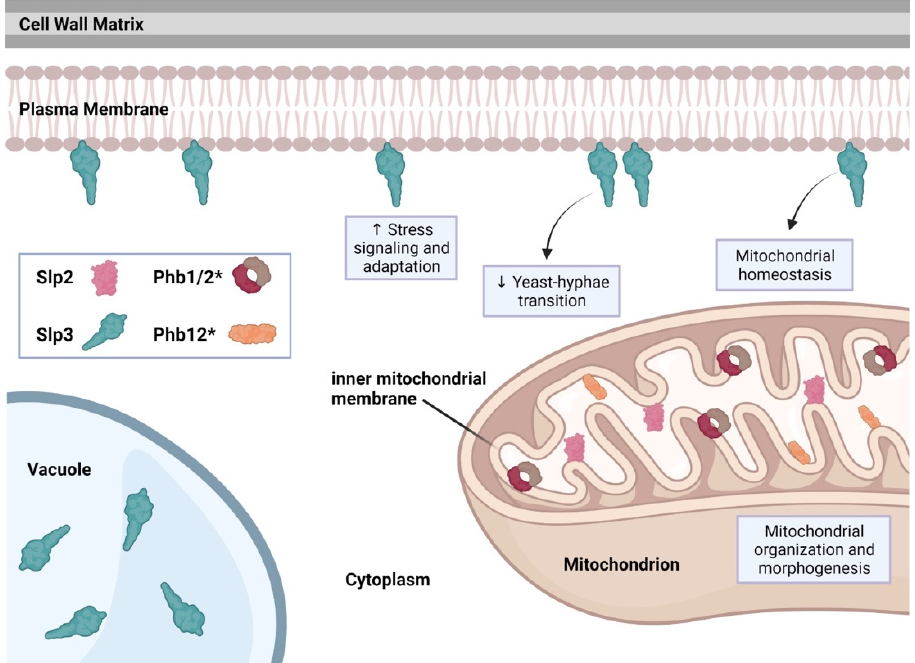
Figure 2. SPFH protein distribution and function in C. albicans . Illustration depicting the cellular localization of SPFH family members Slp2, Slp3, Phb1, Phb2, and Phb12. Asterisks (*) beside Phb1, Phb2, and Phb12 denote that cellular localization of these proteins are only predicted and have not been experimentally confirmed. Biochemical and cytological analyses demonstrated that Slp3 localizes to the plasma membrane and vacuole, and Slp2 localizes to the mitochondria. Known functions associated with Slp3 are depicted in the blue boxes. Slp3 production is increased in response to environmental stress (boxed upward pointing arrow). Slp3 production is decreased in the yeast-to-hyphae transition (boxed downward pointing arrow). Figure adapted from references [5,6] and our unpublished findings and created with Biorender.com. Table 1. SPFH proteins with known functions in fungi. SPFH protein localization and function for each fungal species listed have been experimentally confirmed in the referenced literature.